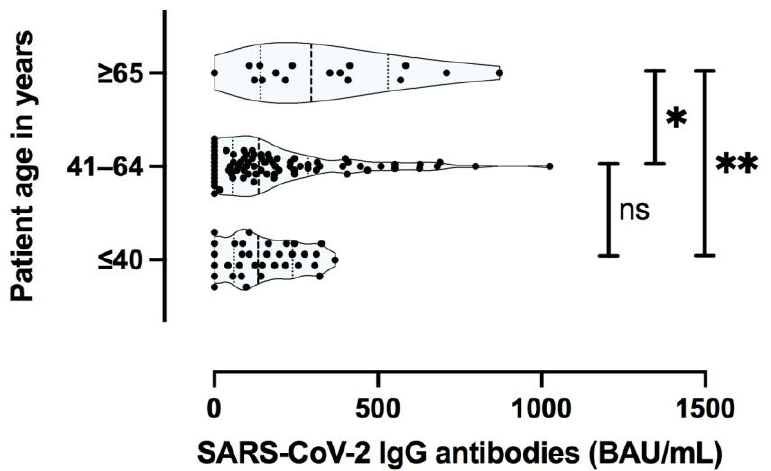
Figure 9. SARS-CoV-2 immunoglobulin G (IgG) antibodies by age (years). ** p < 0.005; *, p < 0.05; ns, not statistically significant.